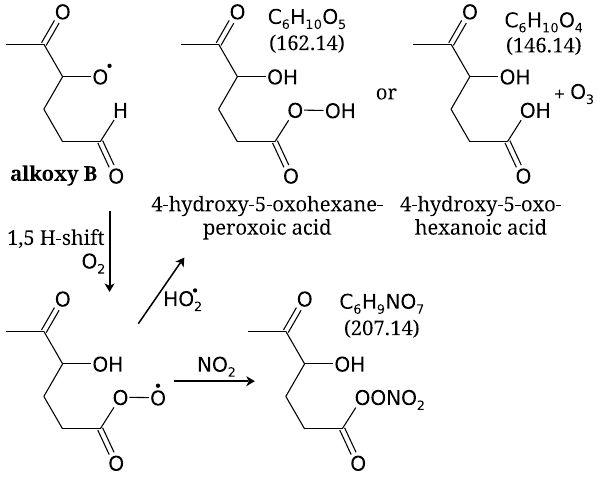
Fig. 8. Chemical mechanism of the reaction between the peroxy- (cid:5) acyl radical with the hydroperoxyl radical (HO ) forming either 2 a peracid or an organic acid and ozone (O 3 ). In the presence of nitro- (cid:5) gen oxides (NO x ), the HO concentration will be reduced by nitro- 2 gen monoxide (NO) and a peroxyacyl nitrate (PAN) can be formed from the reaction of the peroxyacyl radical with nitrogen dioxide (NO 2 ). The numbers in brackets correspond to the molar mass of the compounds. Fig. 9. Suggested formation mechanism of succinic acid adapted from the 3-methyl-1,2,3-butanetricarboxylic acid (MBTCA) forma- tion mechanism of M¨uller et al. (2012) (black path). The interme- diate alkyl radical marked in red is expected to react with O 2 pref- erentially by hydrogen atom abstraction to form 4,5-dioxohexanoic acid. For simplification, alkyl radicals are not depicted as they re- act immediately with O 2 to form peroxy radicals. The numbers in brackets correspond to the molar mass of the